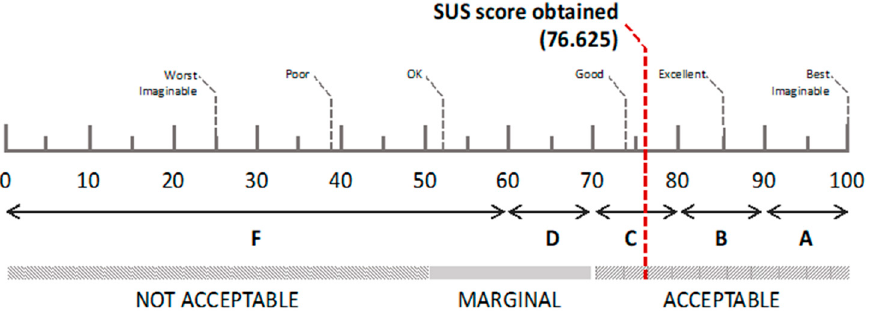
Figure 9. The SUS score of the system (dashed red line), with a visual explanation of adjective ratings, acceptability scores, and school grade scales in relation to the average SUS score [35].